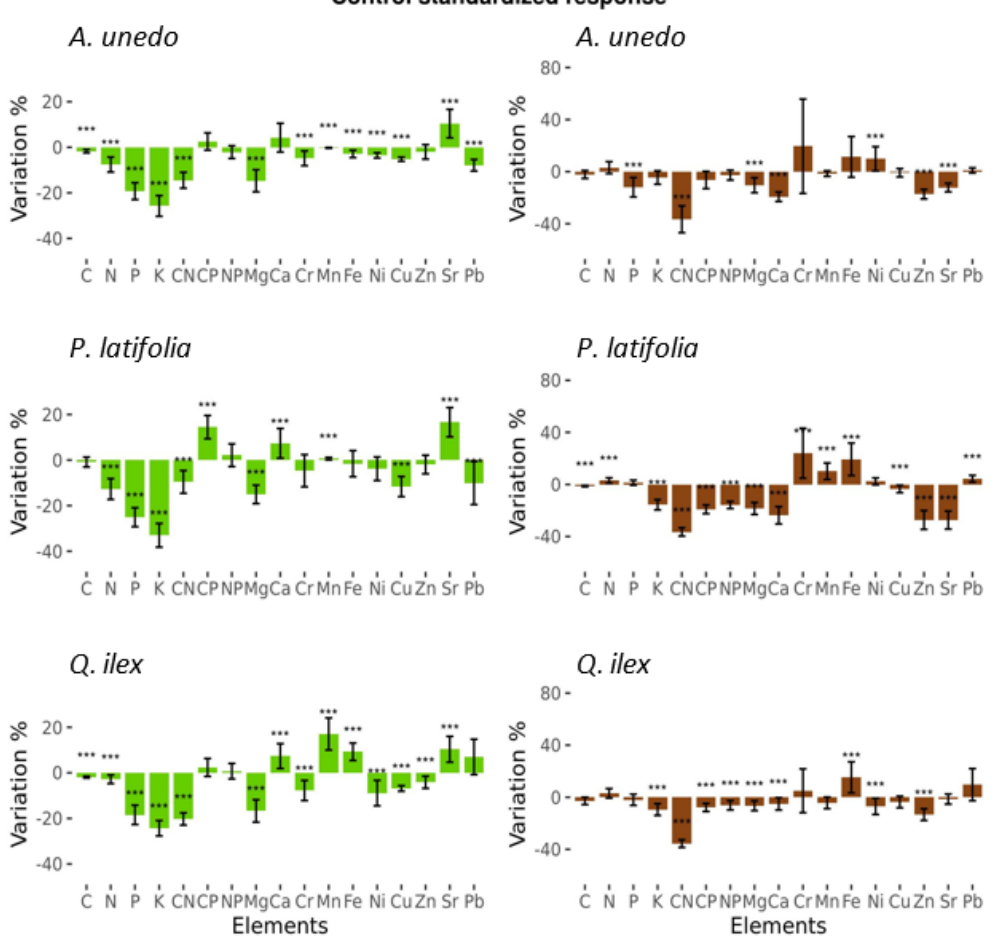
Figure 6. GDA results representation of root 1 and 2. Vectors representing variables, and ellipses representing control and N-fertilized plots measurements. ( a ) Leaves data. ( b ) Litter data.